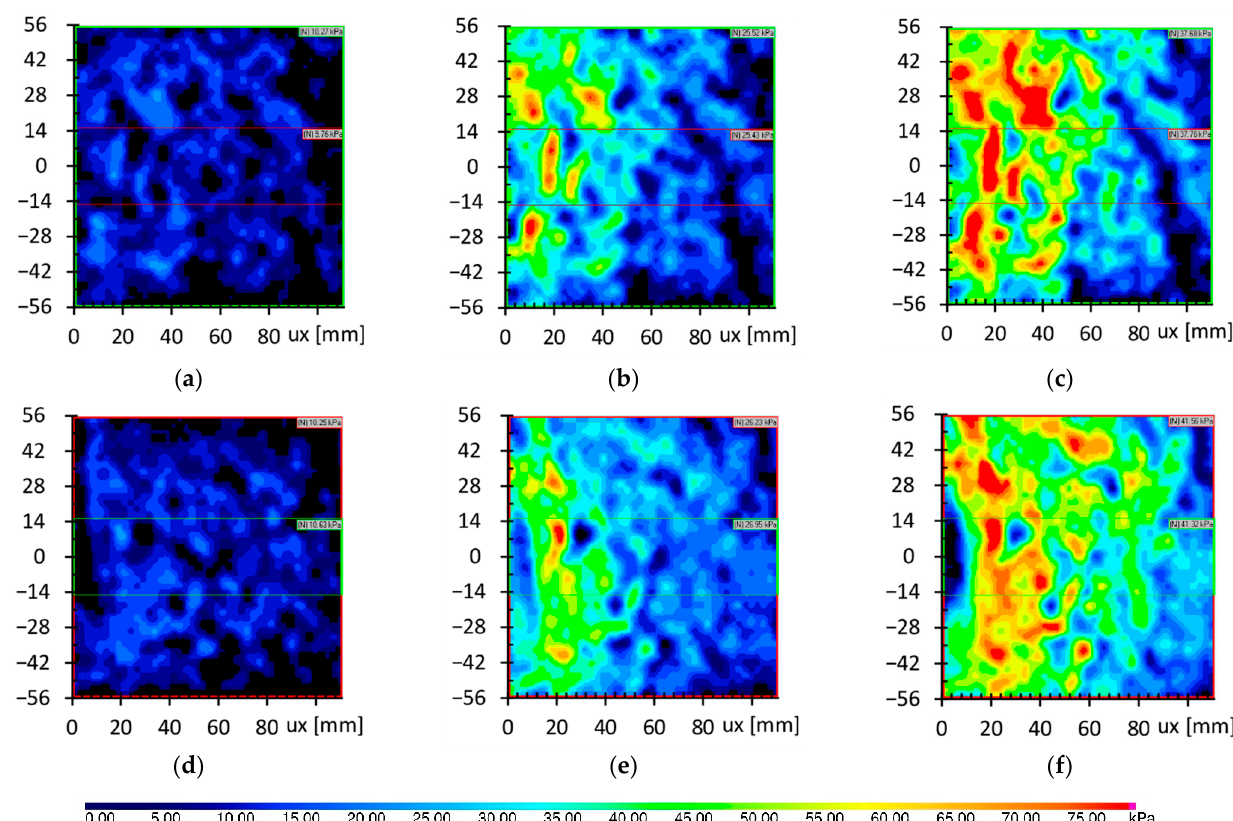
Figure 22. Pressure maps from test P2.R.H.TS and P4.S.H.TS with three different average stresses. The details of the piles are shown in Table 2. ( a ) P2.R.H.TS–10.27 kPa; ( b ) P2.R.H.TS–25.52 kPa; ( c ) P2.R.H.TS–37.68 kPa; ( d ) P4.S.H.TS–10.25